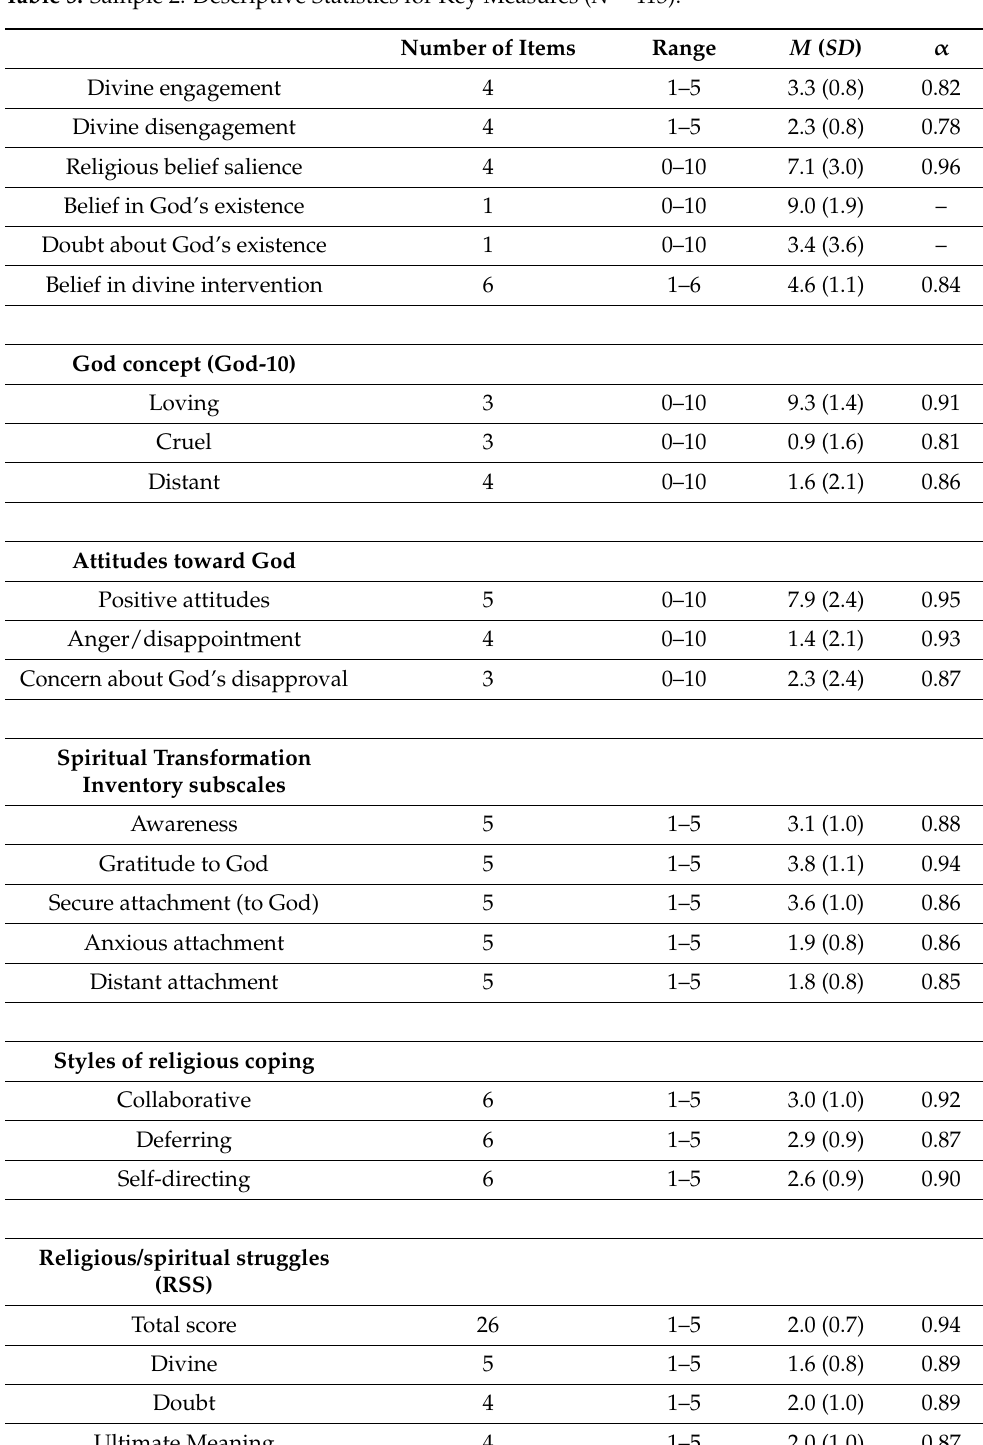
Table 5. Sample 2: Descriptive Statistics for Key Measures ( N =